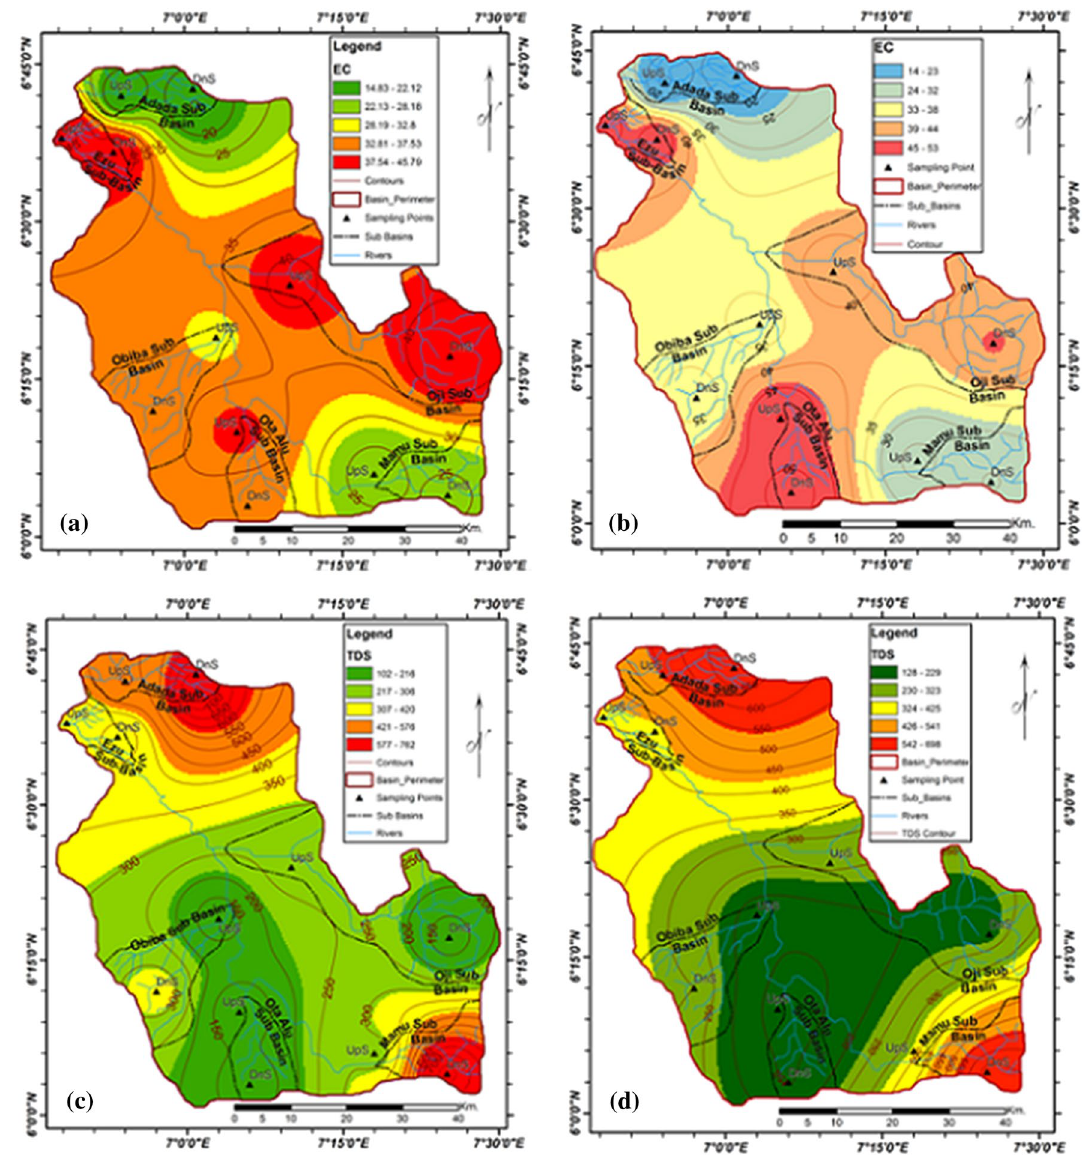
Fig. 11 Spatial distribution of EC and